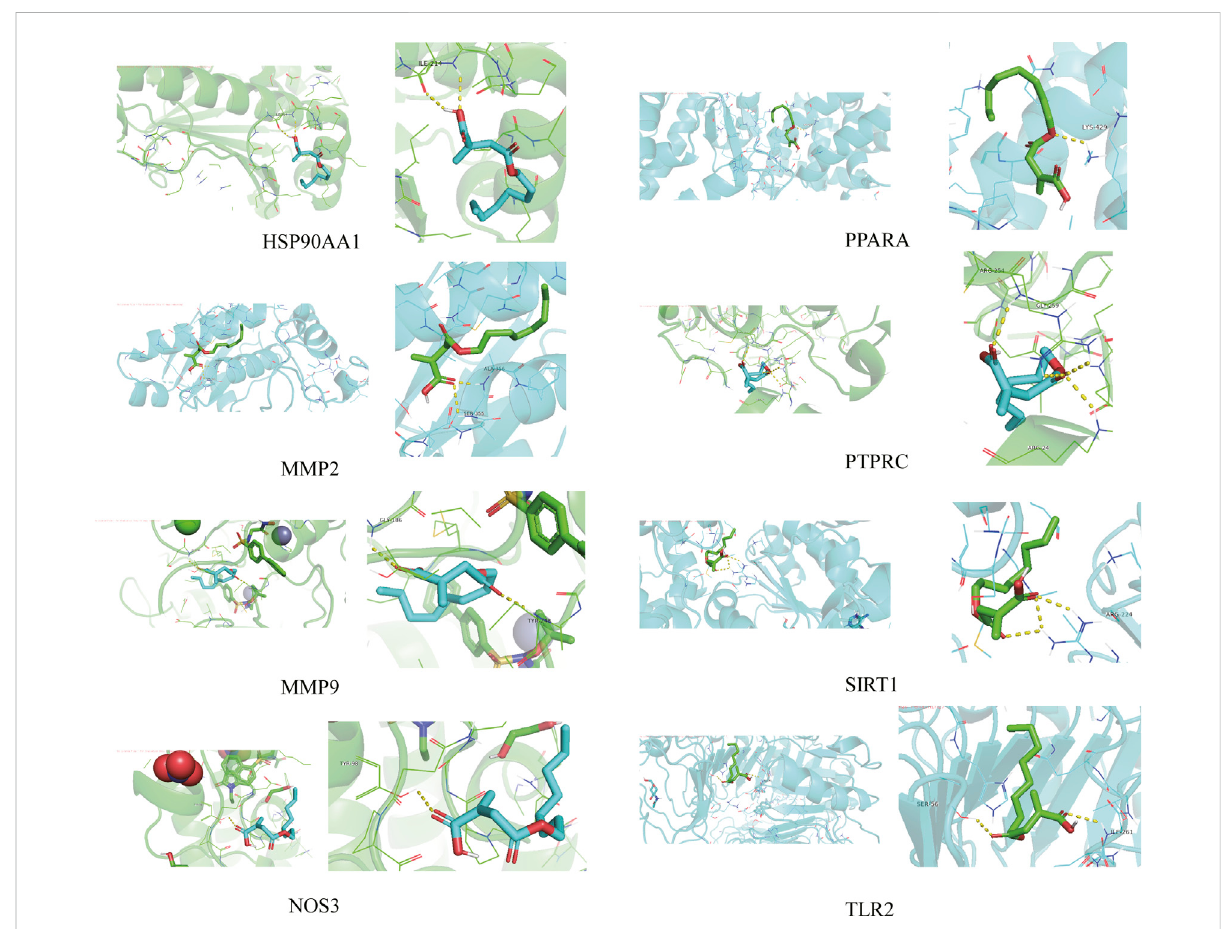
FIGURE 11 Thevisualizationof4-OIdockingwitheightHubtargetmolecules.ThedockingresultsoftheHubtargetsaredisplayedbyPyMOLsoftware,and the yellow dotted line represents the interaction line between the target and the compound.